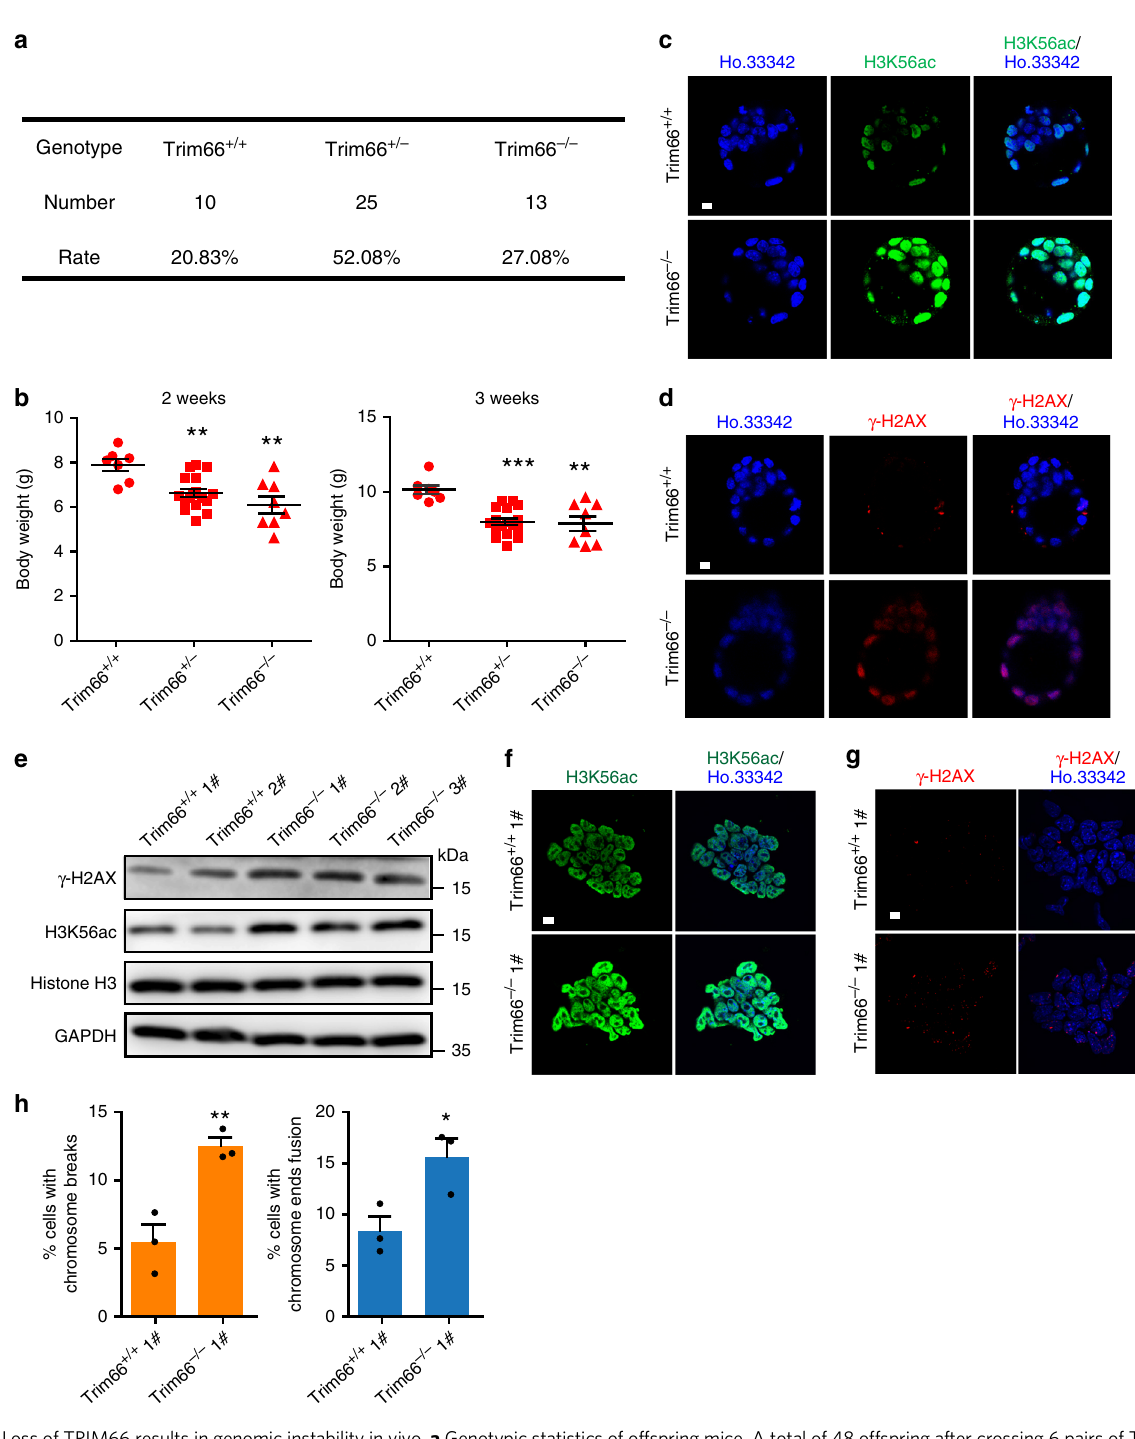
Fig. 7 Loss of TRIM66 results in genomic instability in vivo. a Genotypic statistics of offspring mice. A total of 48 offspring after crossing 6 pairs of Trim66 + / − mice. b Statistics of the body weight of mice offspring aged 2 or 3 weeks. c Representative immuno fl uorescence images of H3K56ac in blastocysts of WT Trim66 + / + and Trim66 − / − mice. Scale bar, 10 μ m. d Representative immuno fl uorescence images of γ -H2AX in WT and Trim66 − / − blastocysts. Scale bar, 10 μ m. e Immunoblot analysis of the levels of γ -H2AX and H3K56ac in the primary Trim66 + / + and Trim66 − / − ESCs. f , g Representative immuno fl uorescence images of H3K56ac and γ -H2AX in the primary Trim66 + / + and Trim66 − / − ESCs. Scale bar, 10 μ m. h Quanti fi cation of chromosomal breakage (left) or chromosome ends fusion (right) in primary Trim66 + / + and Trim66 − / − ESCs. More than 100 cells are examined in each sample. *represents a difference from Trim66 + / + mice or primary Trim66 + / + ESCs. Data are presented as the means±SEM. Statistical signi fi cance is determined by two-tailed Student ’ s t -test. * p < 0.05, ** p <0.01, *** p <0.001. Source data are provided as a Source Data fi